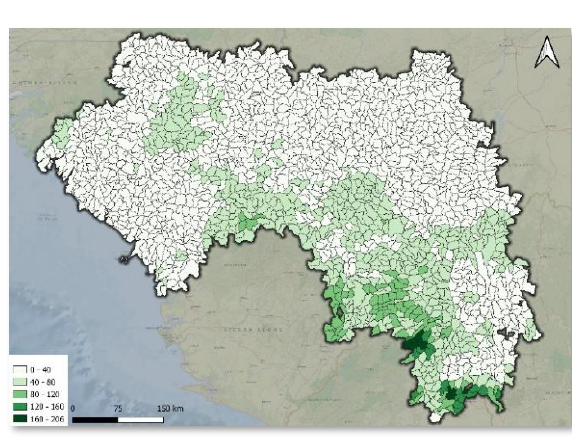
Figure 7. Living above-ground biomass in 2015 (t/ha)